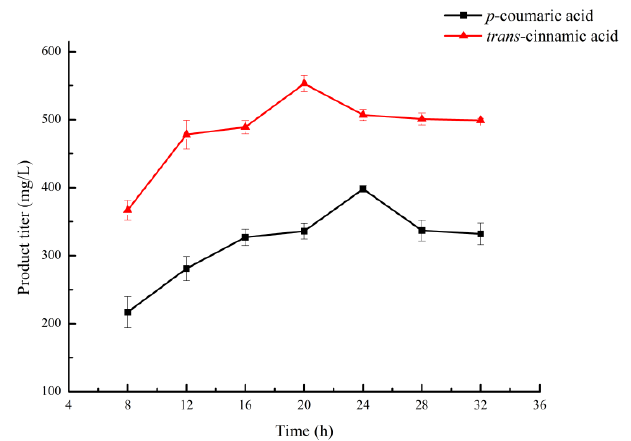
Figure 4. Effect of time on conversion of L-Phe and L-Tyr to trans -cinnamic acid and p -coumaric acid by E. coli BL21(DE3)/pETDuet-1- RgPAL . Reaction conditions: Temperature: 42 °C; Medium: pH by E. coli BL21(DE3)/pETDuet-1- RgPAL . Reaction conditions: Temperature: 42 ◦ C; Medium: pH 9.0 9.0 10 mM Glycine-NaOH; L-Phe and L-Tyr 1 mg/mL; Cell amounts: 6.67 g/L. 10 mM Glycine-NaOH; L-Phe and L-Tyr 1 mg/mL; Cell amounts: 6.67